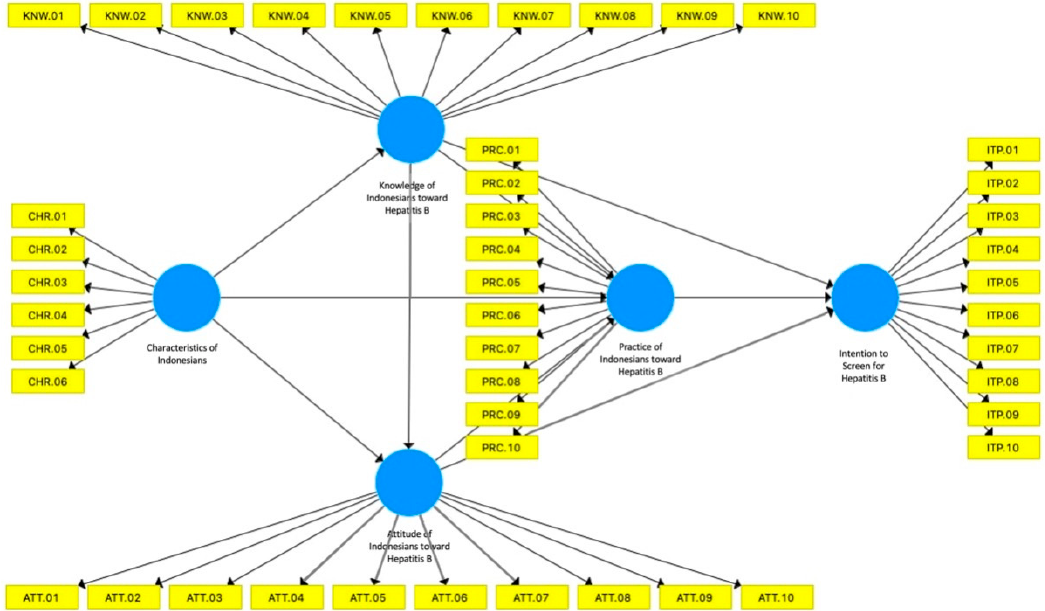
Figure 2. Initial conceptual model of Respondents’ Characteristics, Knowledge, Attitudes, Practice, and Intention for screening of Hepatitis B; note that yellow boxes correspond to the questions provided for each